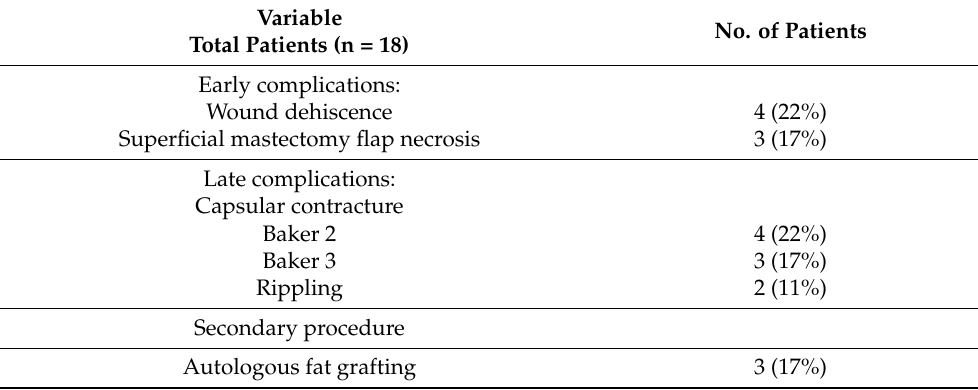
Table 3. Complications after direct-to-implant